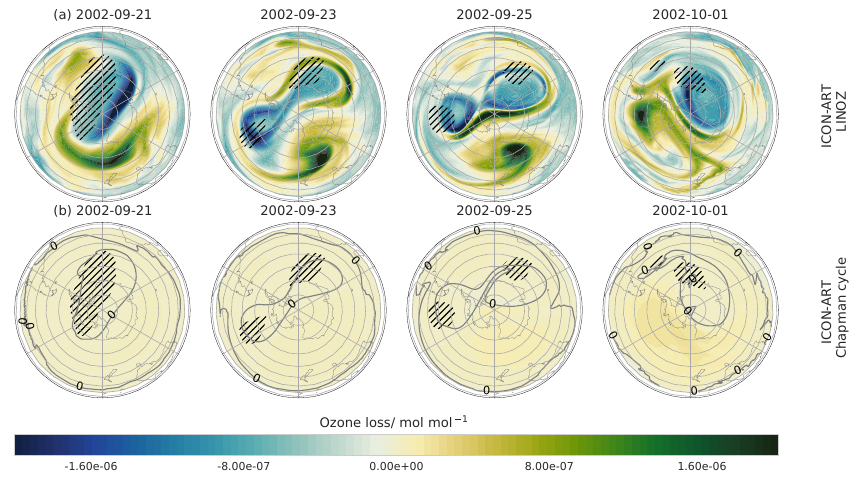
Figure 5. Difference of the passive and active ozone tracers (molmol − 1 ) at 50hPa over Antarctica. Daily averages are shown for two ICON- ART simulations for the Linoz chemistry scheme (a) and for the extended Chapman cycle chemistry (b) . For the loss rate of the Chapman cycle, the zero contour line is added. Shaded areas indicate temperature regions below